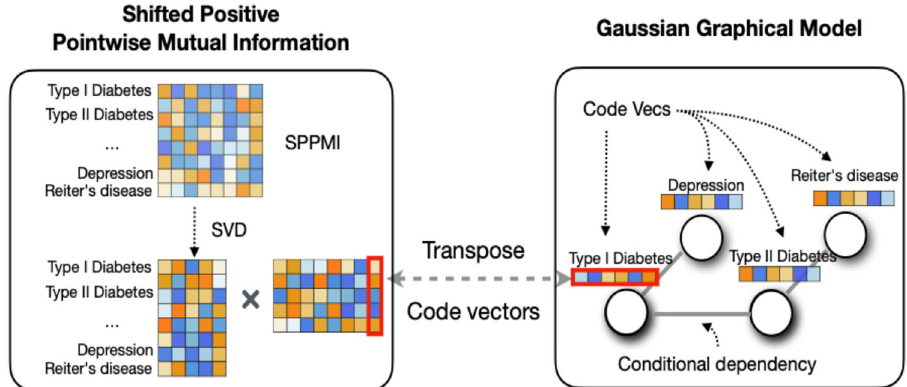
Fig. 5 The left panel describes the key steps for learning the embedding vectors: we conduct singular vector decomposition (SVD) on the SPPMI. The right panel describes the statistical model: the embedding vectors follow a Gaussian graphical model where each node of the graph is represented by the